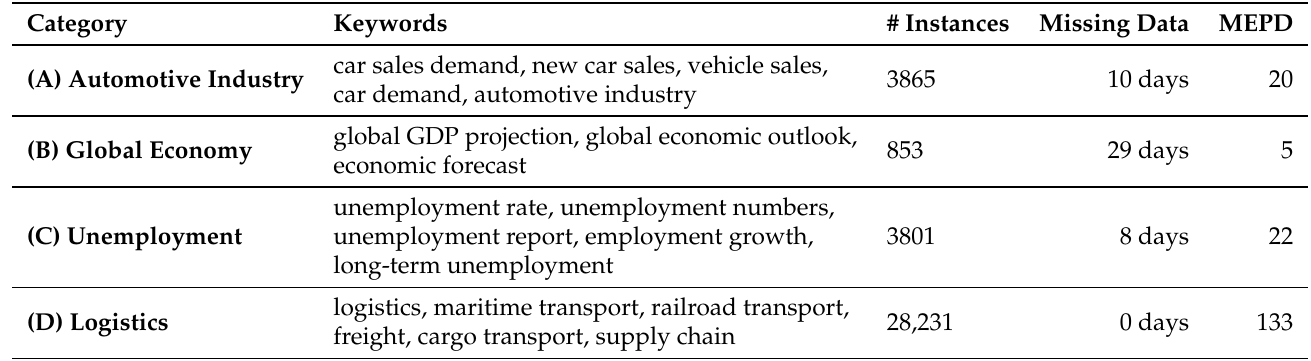
Table 2. Active learning dataset categories, keywords used to query them, the number of instances per category, the number of days without entries for a given category, and the median of events per day for that category (MEPD). “# Instances” stands for “the number of